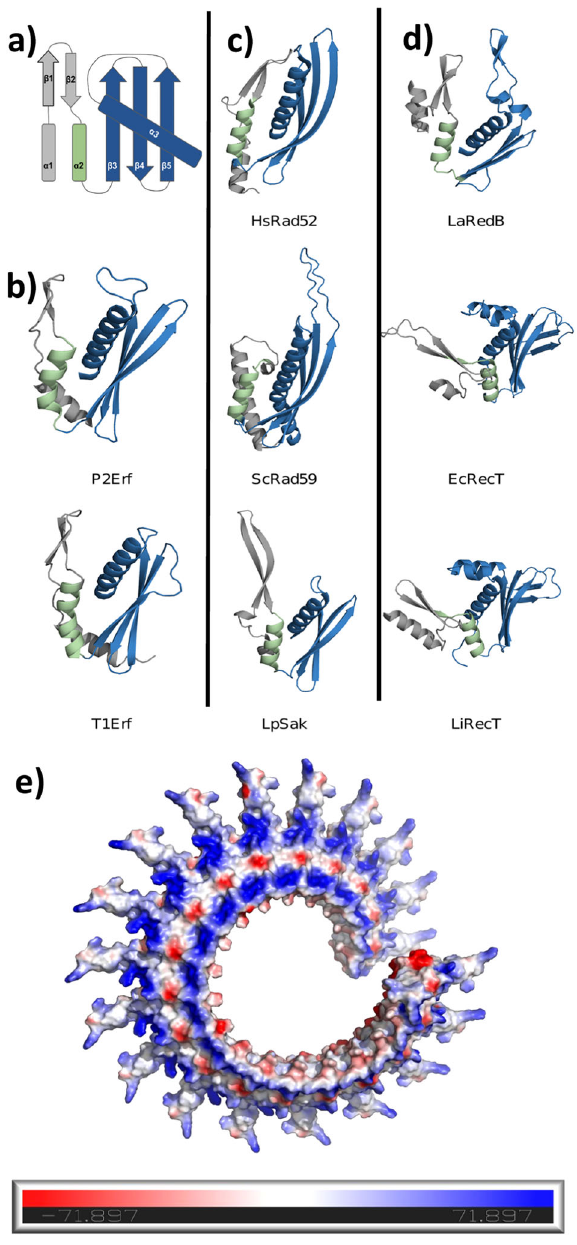
Fig. 1 The Rad52 SSAP superfamily protein fold and AlphaFold predictions. a Diagram of the Rad52 SSAP protein fold secondary structure, using RAD52 secondary structural designations 9,10 , with the most conserved elements in blue and the most variable in grey. b – d Selected examples of the Rad52 SSAP fold from the three SSAP classes. b Erf: E.coli phage P2Erf, E.coli phage T1Erf. c Rad52: H.sapiens RAD52 , S.cerevisiae Rad59; L.lactis phage ul36 SakRad52. d RecT/Red β : λ phage Red β , E.coli rac phage RecT; Li, Listeria innocua RecT. e AlphaFold projected full-length Red β fi lament displaying electrostatic surfaces presenting the positively charged ssDNA binding groove (red) between negatively charged ridges (blue). The C-terminal three α -helical bundle 27 , which is not part of the annealing domain or the published cryo-EM structure 2 but is required for HR 23 , is the perpendicular projection away from the helical axis of the fi